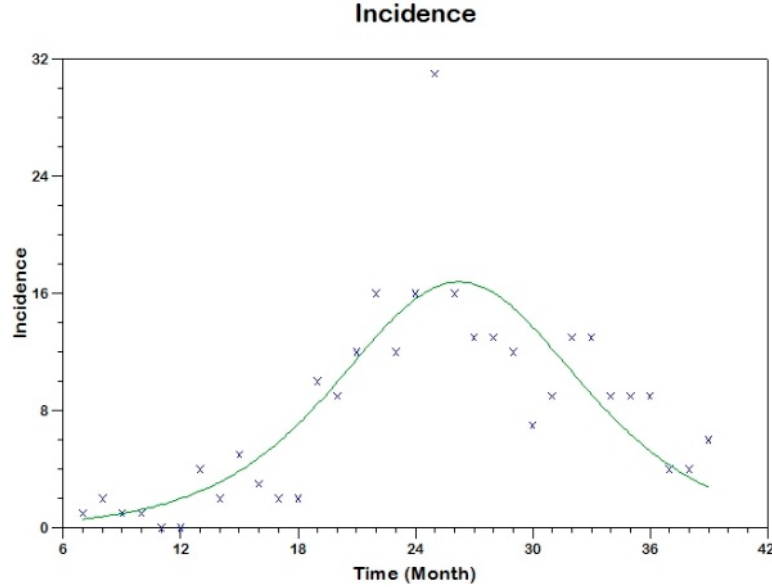
Figure 8. Model fit to the reported incidence of Madrid-Spain outbreak using Method 1. Trop. Med. Infect. Dis. 2018 , 2 ,